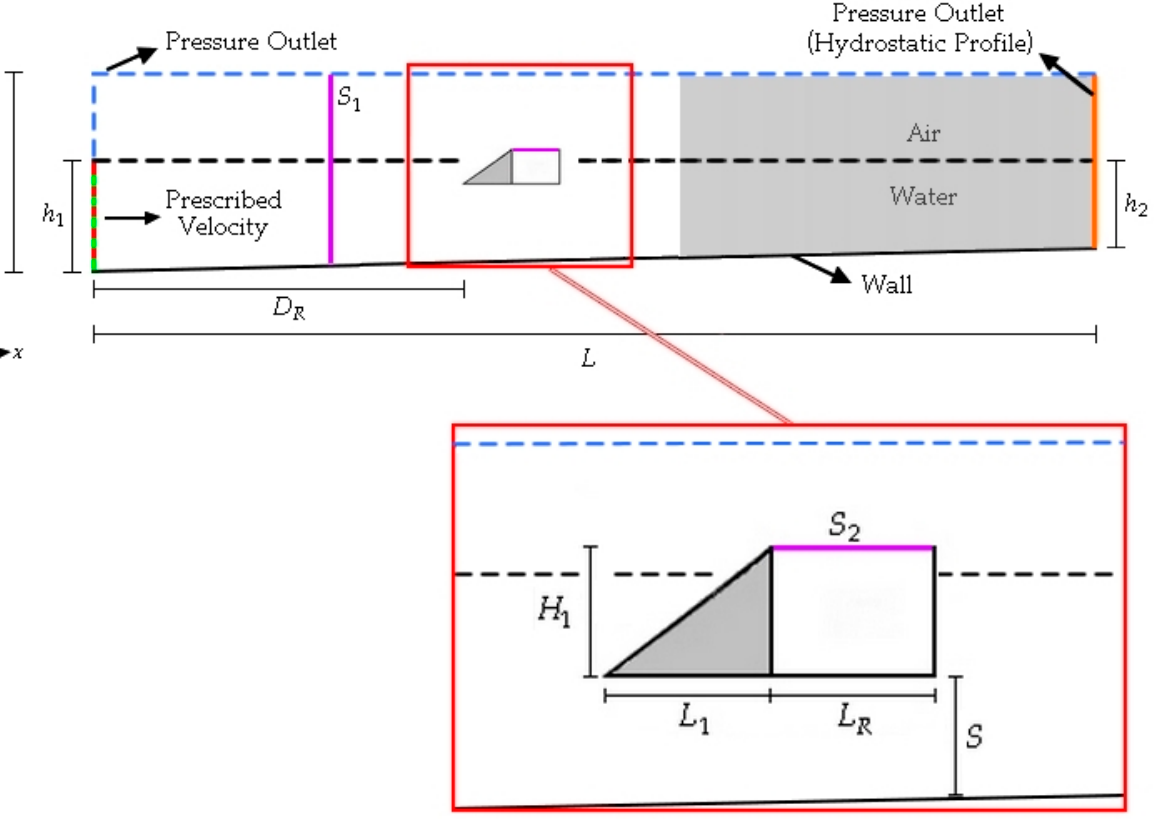
Figure 5. Schematic representation of the two-dimensional computational domain of the overtopping device in the wave channel.